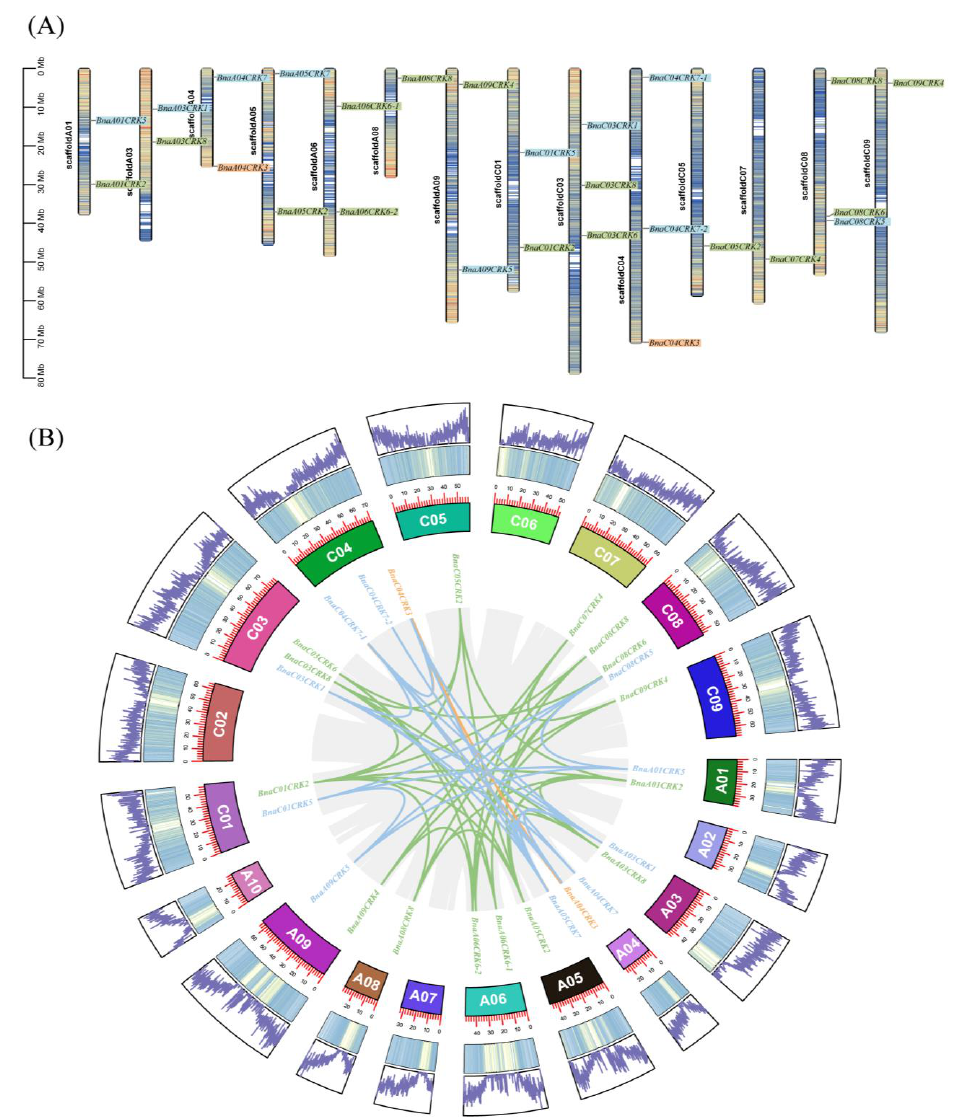
Figure 4. Chromosomal position and intrachromosomal relationship of the BnaCRKs . ( A ) Position of 27 putative BnaCRKs on the B. napus chromosomes. The same highlighted color indicates the genes from the same group. The scale bar shows an 80 Mb chromosomal distance. ( B ) Duplication of the BnaCRKs in B. napus . The lines with the same color are the members of the same BnaCRK group and indicate a segmental duplication pair. Synteny blocks of the B. napus genome are represented by gray lines in the background. The B. napus chromosomal gene density profile is shown by the outside circle, and the chromosome number is shown as a separate color box with a scale size in Kb.